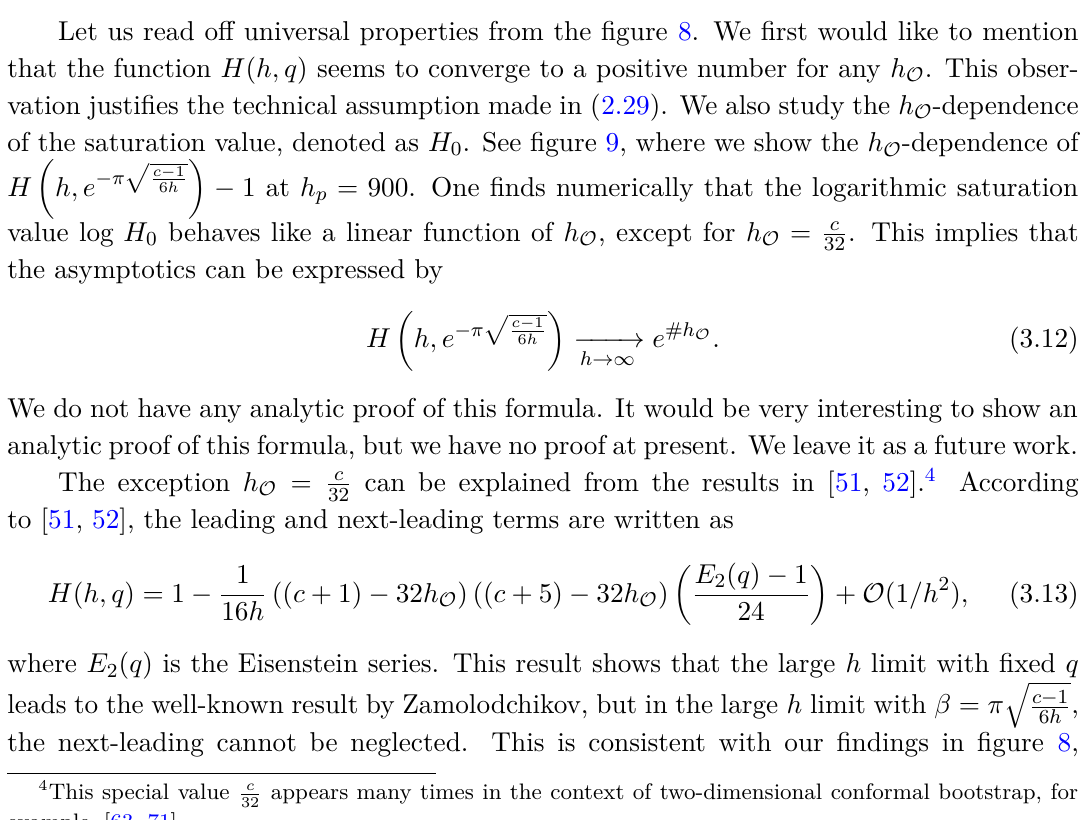
Figure 8 . Colored curves show the h -dependence of H . For convenience, we introduce a normalized internal dimension η = 32 h O = c , c , c , c , c , c 6 8 10 12 32 64 One can see that for any h , the function H converges to some positive values, which we want O to